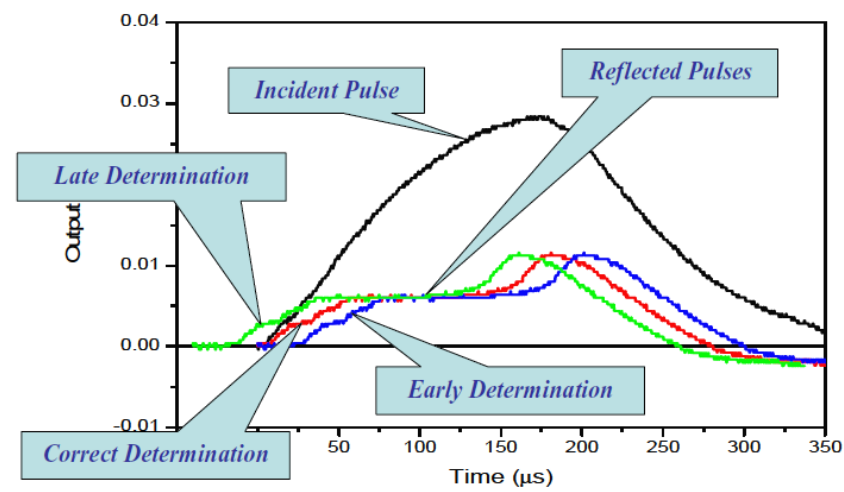
Figure 6. Determination of reflected pulse, the correct and incorrect method. Reprinted with permission from Springer, Split Hopkinson (Kolsky) Bar by Chen and Song (2011) [14].